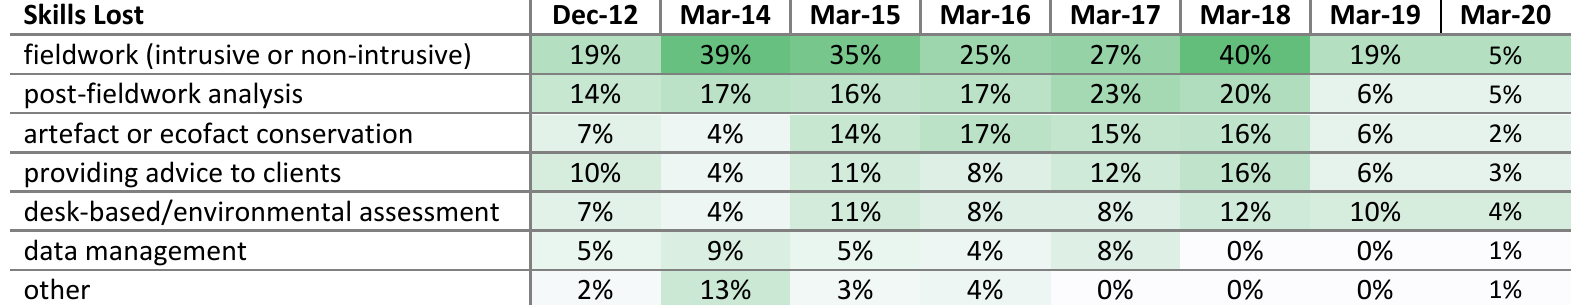
Table 211: Skills lost from 2012 to 2020. Percentages calculated on total responses to all skills questions and not just those to this specific question. The assumption is made that those who did not respond did so because they had no losses.